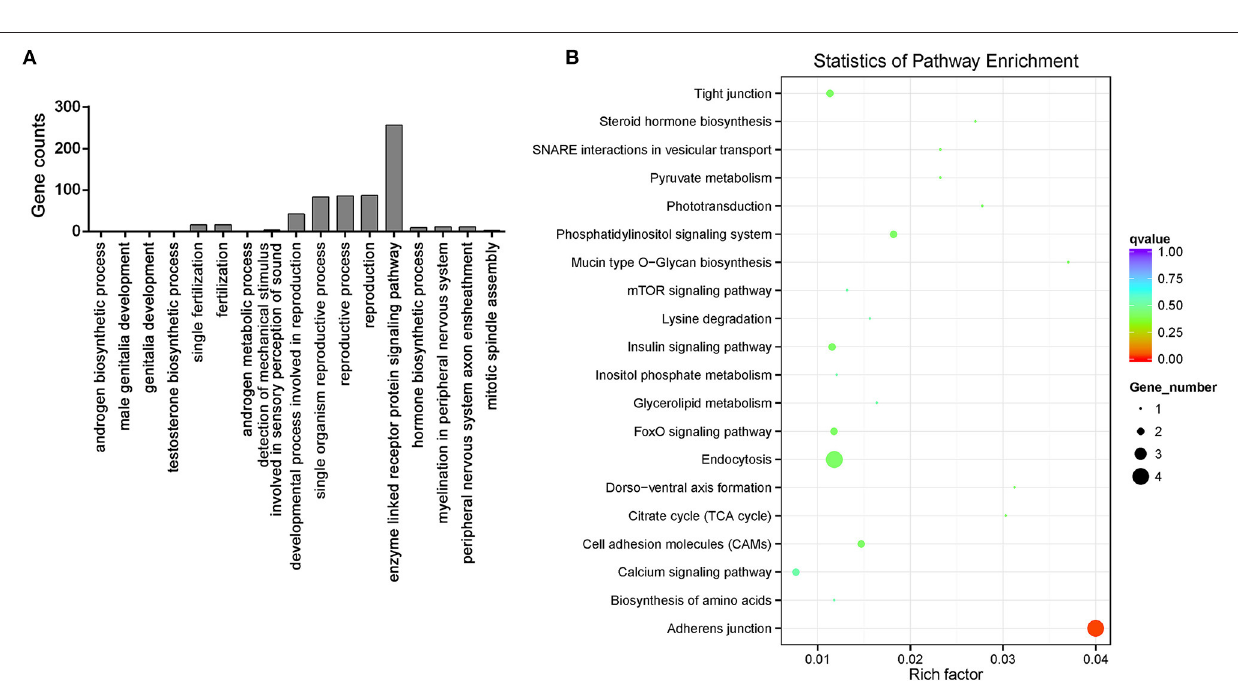
FIGURE 4 | Annotation of the host genes of differentially expressed circRNAs. (A) Gene Ontology (GO) annotation analysis of the host genes of differentially expressed circRNAs. (B) KEGG pathways of differentially expressed circRNAs host